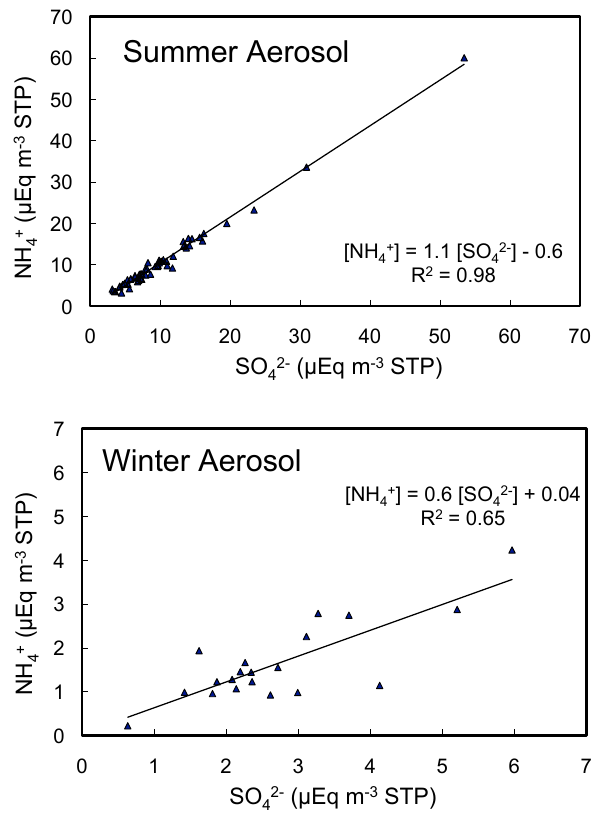
Fig. 6. Ammonium as a function of sulfate in atmospheric aerosol sampled at the Vallot observatory in summer (top) and winter (bot- tom) between 1999 and 2010. Concentrations are given in ngm − 3